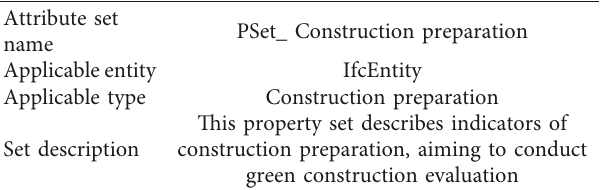
Table 2: IFC construction preparation attribute set